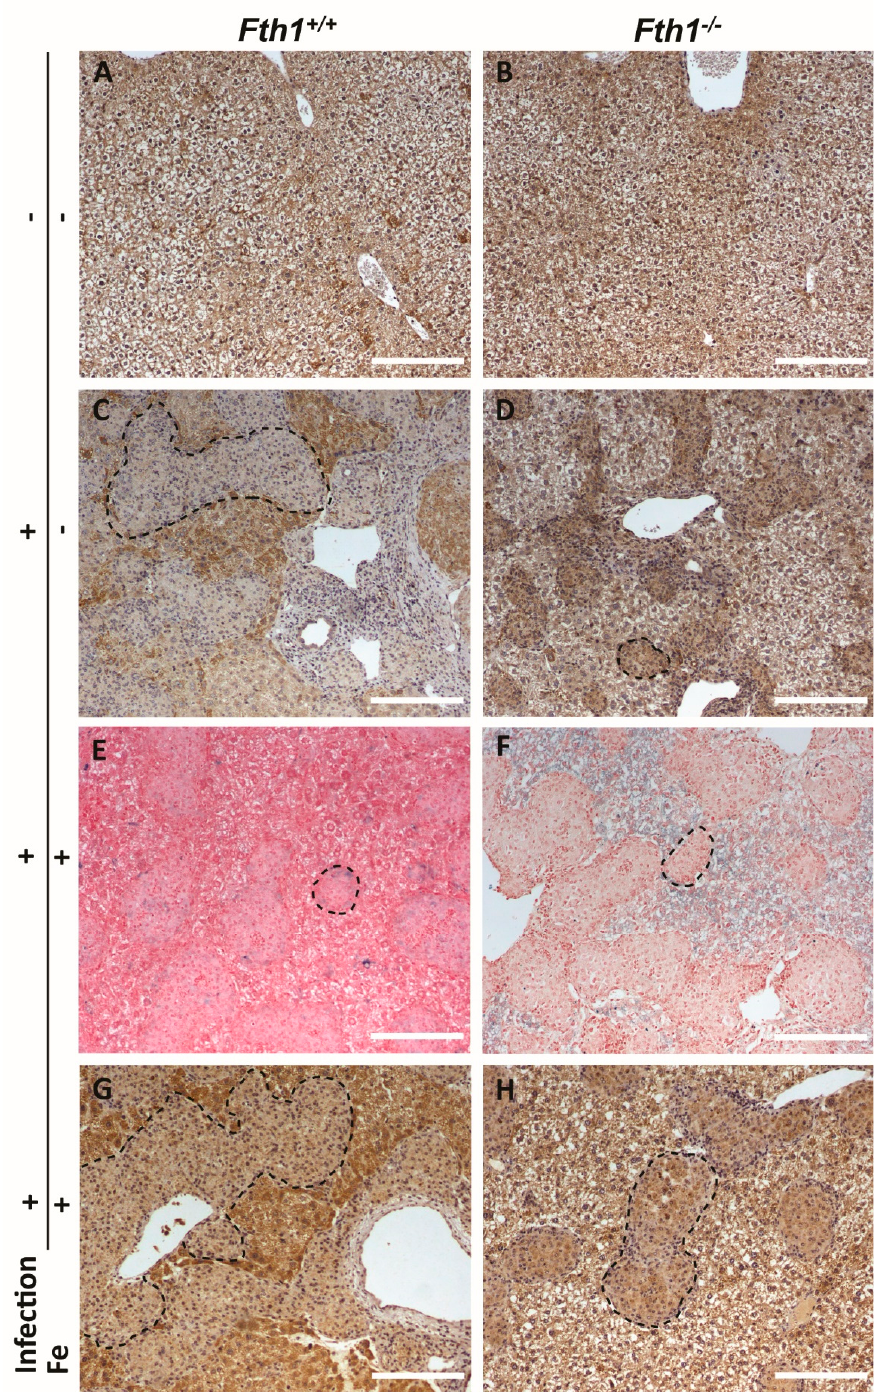
Figure 5. Effects of infection and myeloid Fth1 deficiency in iron and ferroportin distribution in the liver. Liver sections were obtained from ( A , B ) noninfected mice or ( C – H ) mice infected with M. avium for 60 days. Sections were stained for ( A – D , G , H ) ferroportin, using immunohistochemistry (brown staining) or for ( E , F ) iron, using the Perls’ method (blue staining). ( E – H ) Mice were intraperitoneally injected with 10 mg of iron, as iron ‒ dextran, 10 days before infection. Representative images of at least three animals per experimental condition. Representative granulomas are outlined. Scale bar: 200 µm.